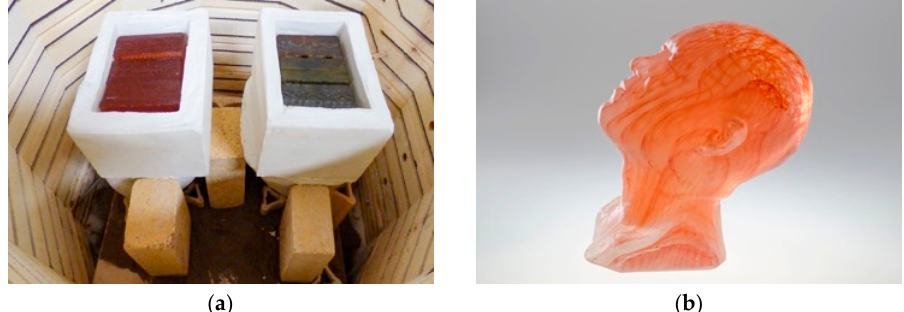
Figure 6. Process for loading kilnformed sections into lost-PLA investment. ( a ) In the first setup, a rectangular feed filled with printed glass sits atop the mold. ( b ) Image distortion is seen in the final result. Photos: ( a ) The Author and ( b ) Bullseye Glass Co.